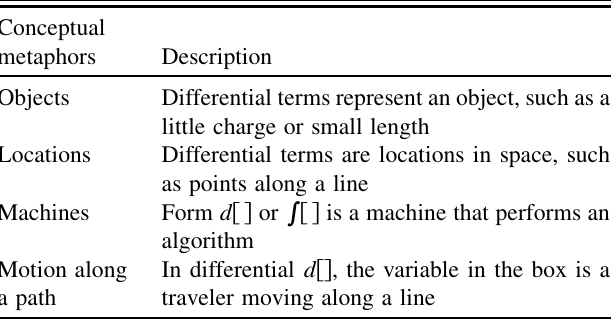
TABLE I. List of resources about differentials identified in our data set.